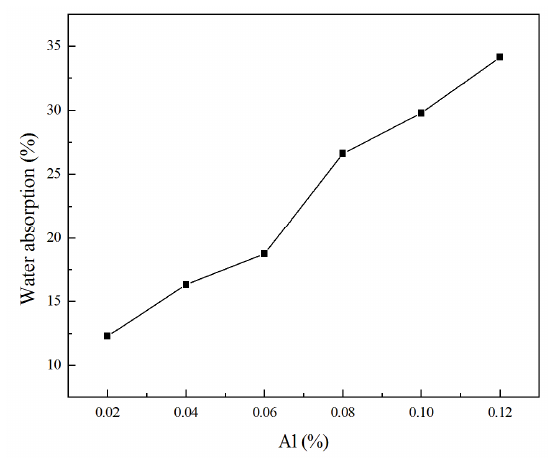
Figure 4. Water absorption of GLWC vs. Al powder content.